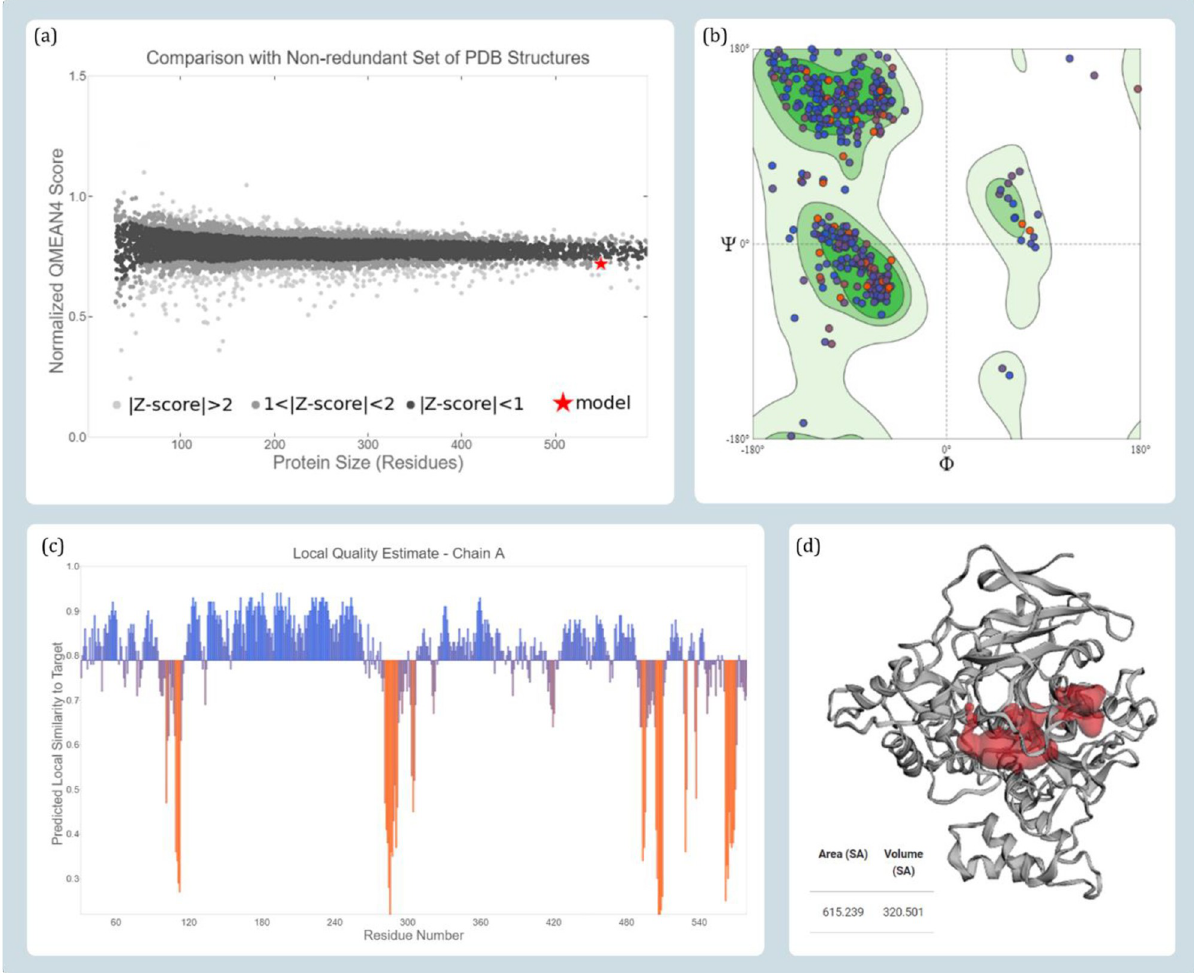
Fig 2. Quality estimate parameters for modelled BChE protein (a) comparison with non-redundant set of PDB structures (b) Ramachandran plot (c) local model quality estimate and (d) binding pocket identification of modelled protein predicted by CASTp 3.0.